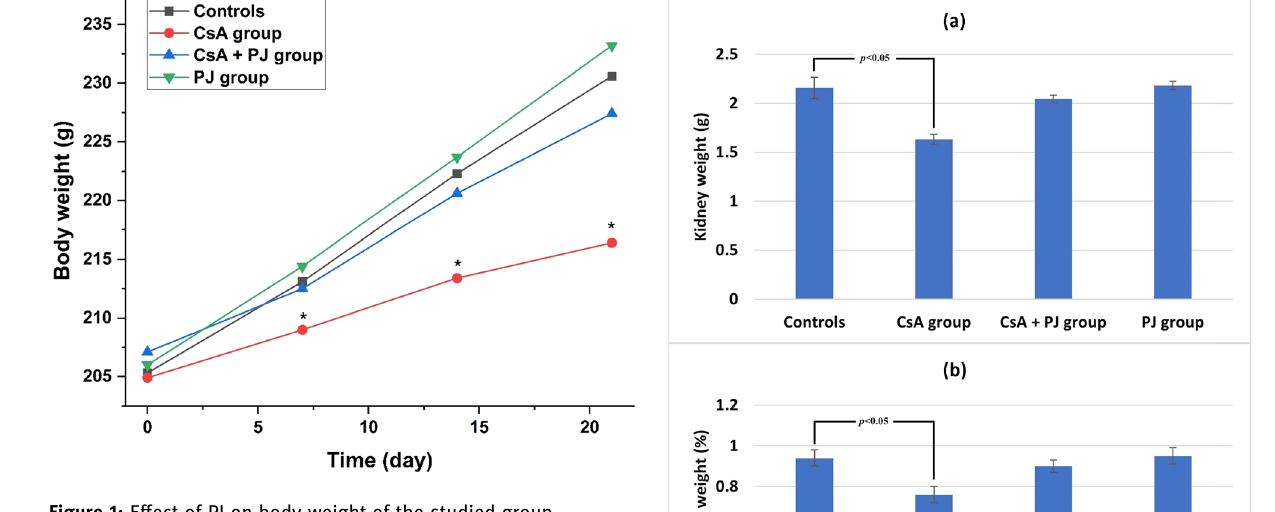
Figure 1: E ff ect of PJ on body weight of the studied group ( * signi fi cantly di ff erent from the control group at P < 0.05 ) .